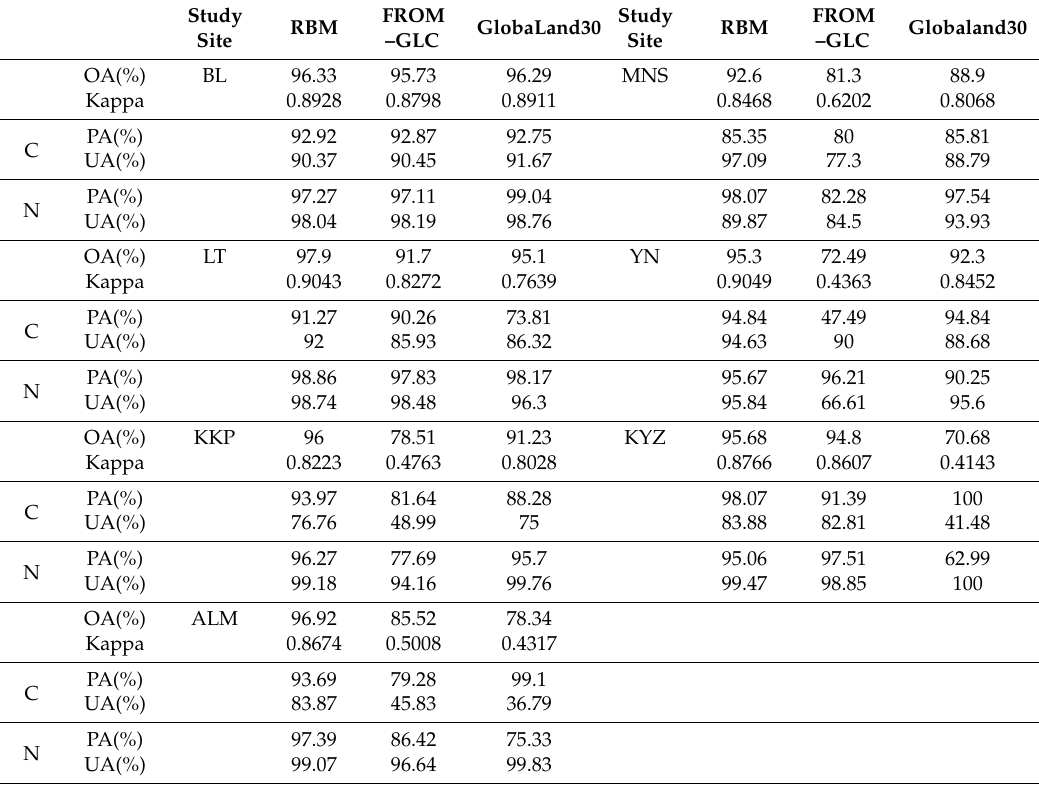
Table 5. Classification accuracy comparison with FROM–GLC and GlobaLand30 in seven study regions.